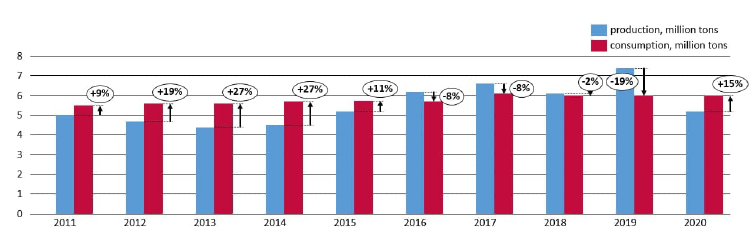
Figure 20. Production and consumption of sugar in the Russian